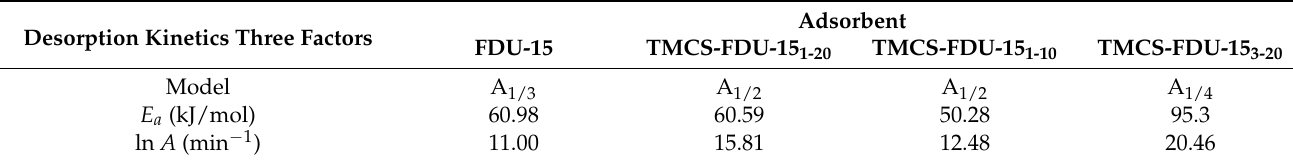
Table 4. Three factors of desorption kinetics of Nap on FDU-15 and modified FDU-15. Desorption Kinetics Three